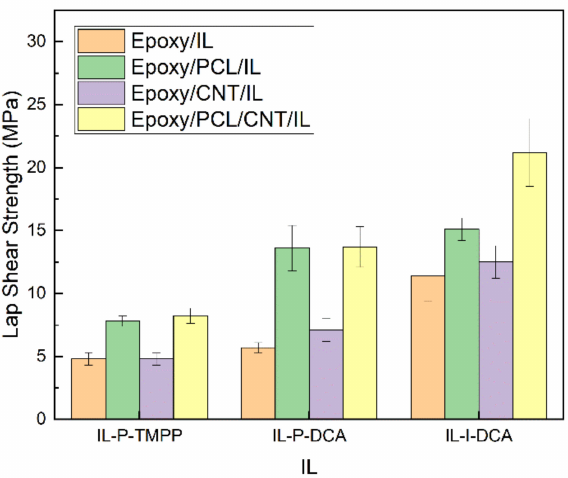
Figure 9. The lap shear strength of the epoxy/PCL/CNT NCs cured with the three different ILs, as well as that of the reference epoxy/IL, epoxy/PCL/IL and epoxy/CNT/IL